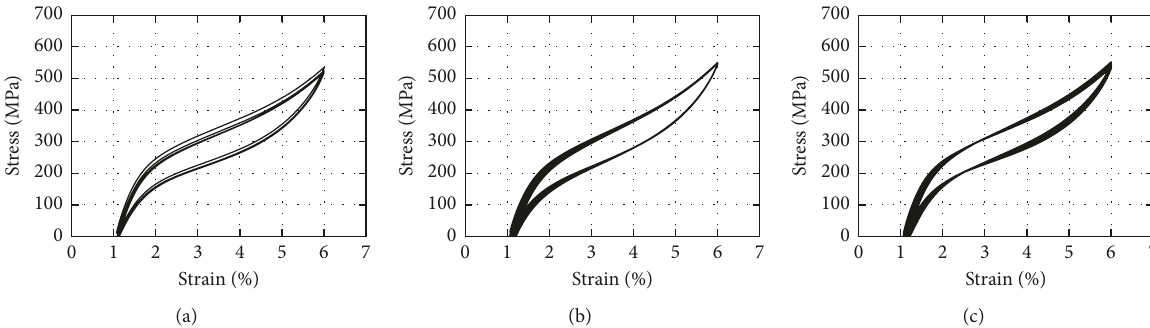
Figure 10: Stress-strain responses under different loading rates. Stress-strain response under loading rate (a) 0.03%, (b) 0.15%, and (c) 0.3%.